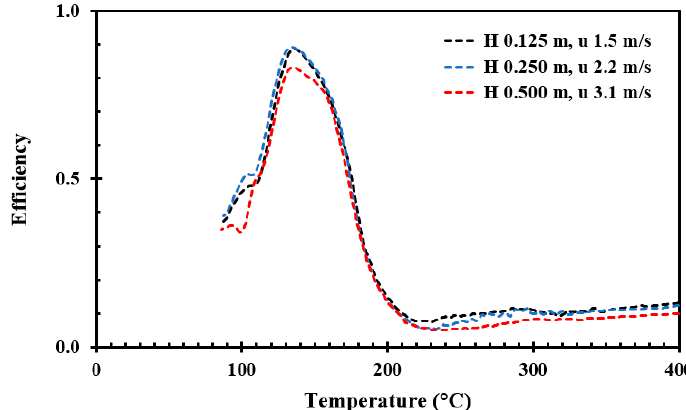
Figure 19. Cooling e ffi ciency for 700 ppm acetone solution for droplet diameter 2.5 mm, horizontal orientation. Impingement heights and speeds are given in the figure label.